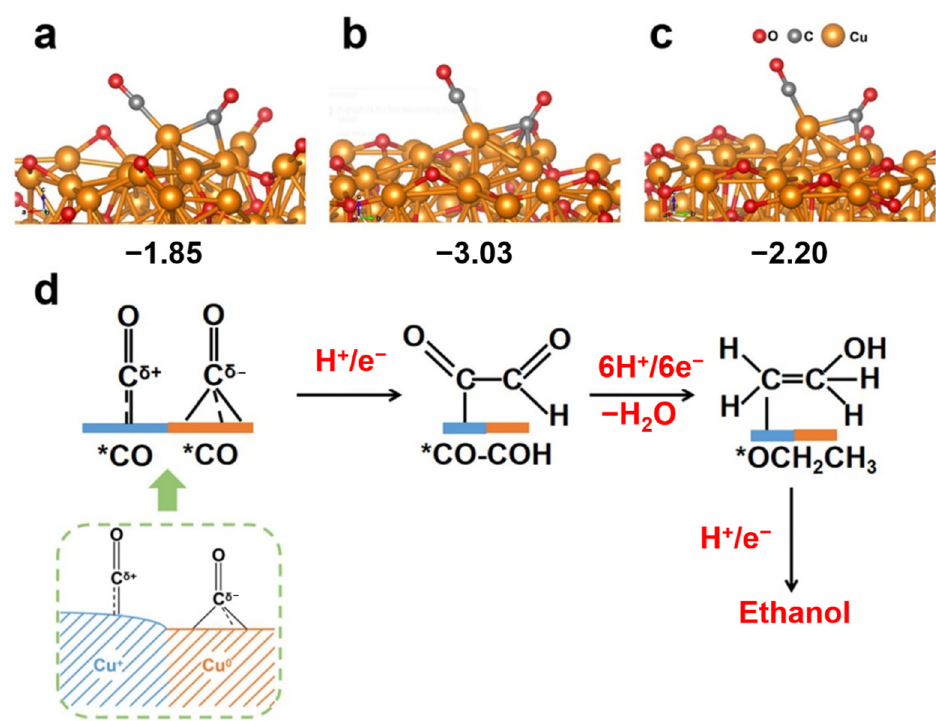
Figure 16. Free energy of *CO formation for ( a ) Cu 0 , ( b ) Cu 0.6 , and ( c ) Cu 1.2 . ( d ) Scheme of the reaction pathway of a CO 2 RR.